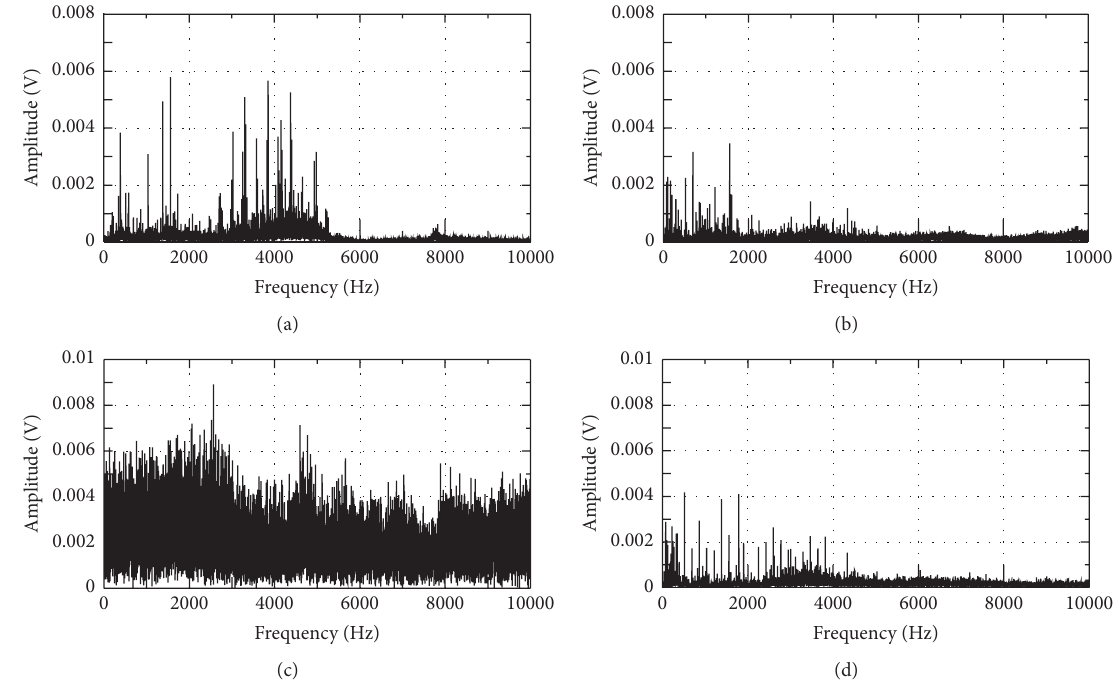
Figure 14: Frequency spectrum diagrams of various signals of axial piston pump. (a) Normal. (b) Swash plate wear. (c) Loose slipper. (d) Sliding shoe wear.